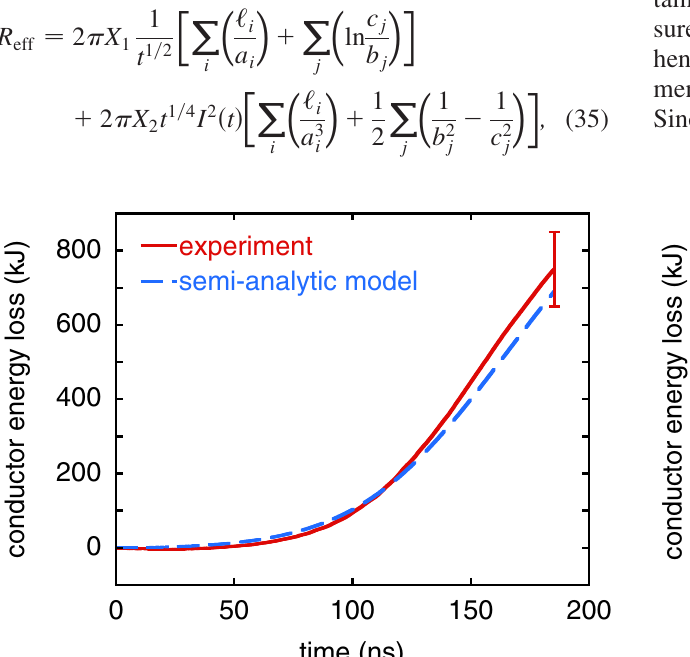
FIG. 5. (Color) Comparison of the measured conductor energy loss on Z-shot 507 with the prediction of the semianalytic model, as given by Eq. (35). The conductor system used as the load on this shot is that illustrated by Fig. 3. The plot includes a representative error